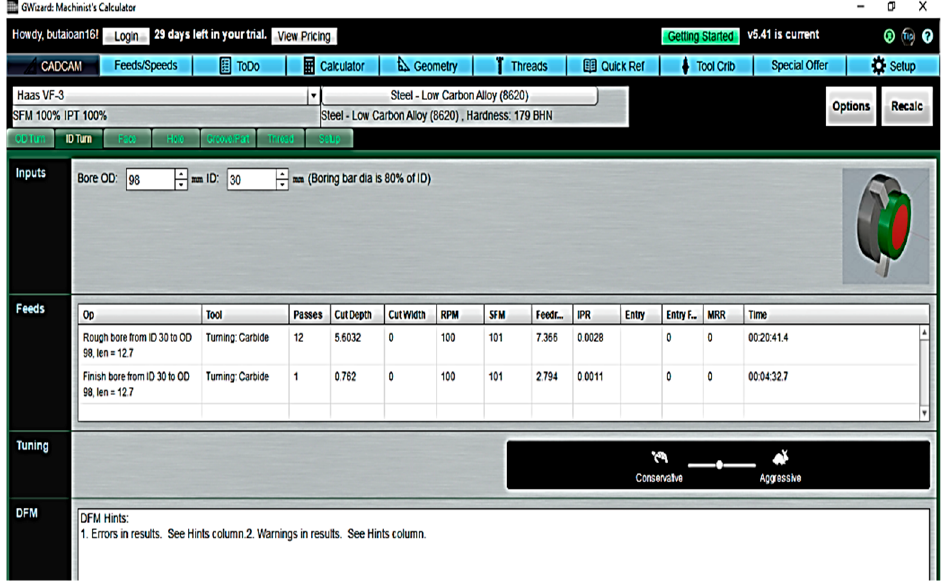
Figure 28. Software for CNC simulation turning the component.